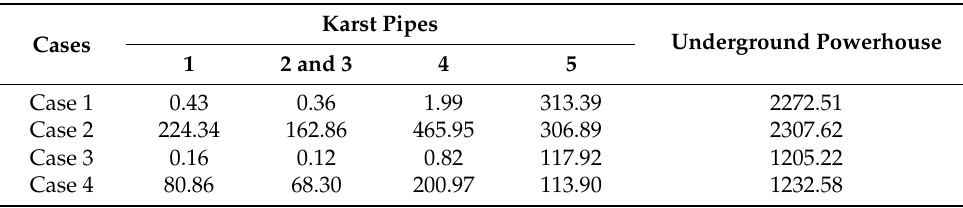
Table 8. Prediction of leakage for karst pipes and powerhouse during the operation period of the reservoir (m 3